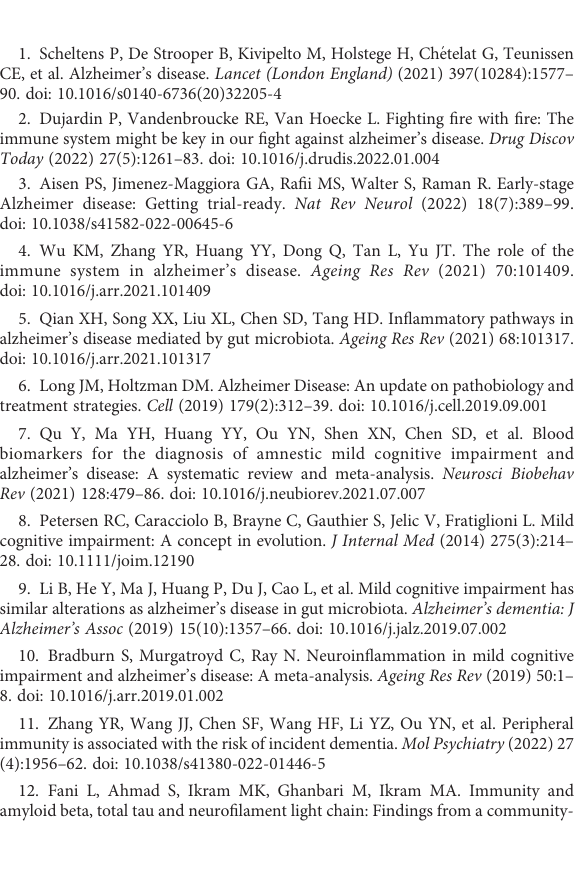
SUPPLEMENTARY FIGURE 1 Flow Chart of this study. HC: healthy control, MCI: mild cognitive impairment, AD: Alzheimer ’ s disease, WGNCA: Weighted Correlation Network Analysis, DEGs: differentially expressed genes, GO: Gene Ontology, KEGG: Kyoto Encyclopedia of Genes and Genomes, LASSO: least absolute shrinkage and selection operator, EC: entorhinal cortex, HP: hippocampus, TC: temporal cortex, FC: frontal cortex, GSEA: Gene Set Enrichment